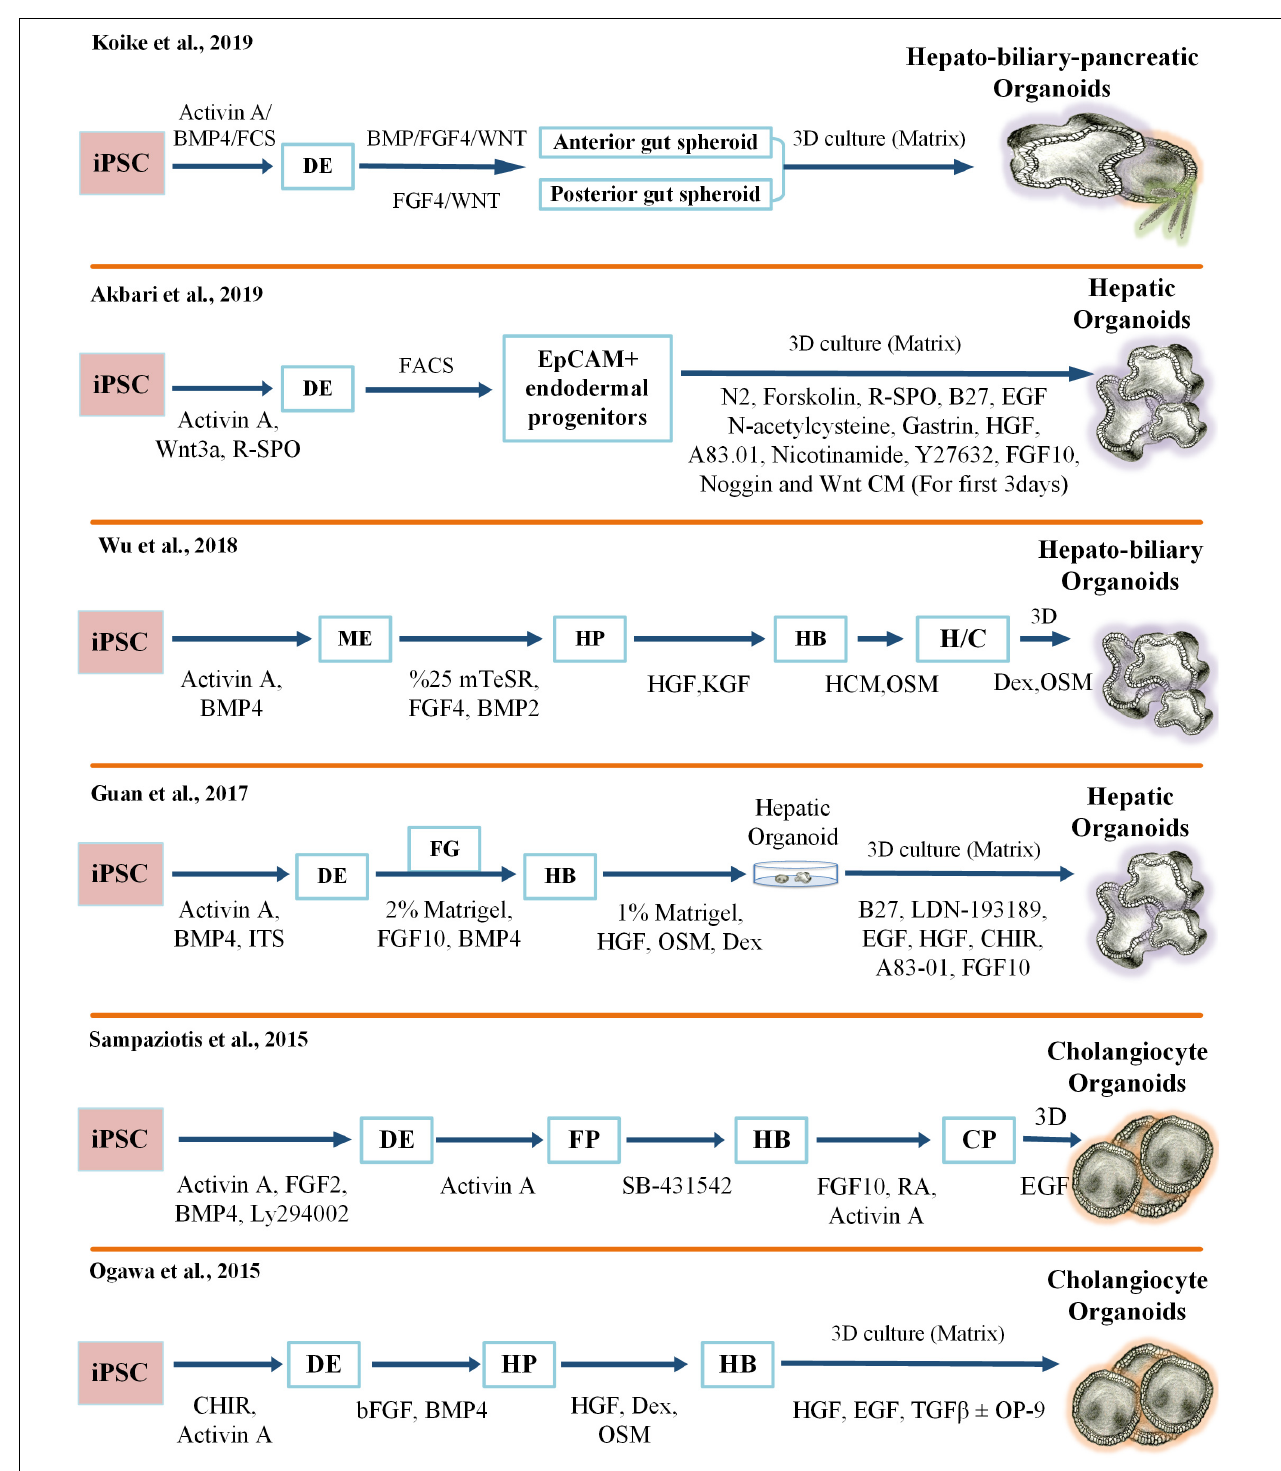
FIGURE 1 | Key protocols for generating iPSC-derived 3D liver organoid cultures. FCS, Fetal Calf Serum; 3D, three-dimensional; FGF, Fibroblast Growth Factor; TGF, Transforming Growth Factor; R-SPO, R-Spondin; EGF, Epidermal Growth Factor; HGF, Hepatocyte Growth Factor; CM, Condition Medium; FACS, Fluorescence-Activated Cell Sorting; EpCAM, Epithelial Cell Adhesion Molecule; iPSC, Induced Pluripotent Stem Cell; BMP, Bone Morphogenetic Protein; ME, Mesoendoderm; HP, Hepatic Progenitor; KGF, Keratinocyte Growth Factor; HB, Hepatoblast; HCM, Hepatocyte Culture Medium; OSM, Oncostatin M; H/C, Hepatocyte/Cholangiocyte; Dex, Dexamethasone; ITS, Insulin-Transferrin-Selenium; DE, Definitive Endoderm; FG, Foregut; FP, Foregut Progenitor; CP, Cholangiocyte Progenitor.